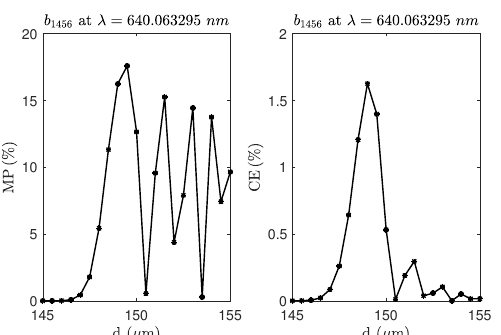
Figure 4. Mode Purity (MP) and Coupling E ffi ciency (CE) as a function of the transverse position d for a WGM defined by the magnetic Mie coe ffi cient b 1456 . The spherical resonator has R = 145 μ m and n r = 1 . 3989. The mode is excited at λ = 640 . 063295 nm.